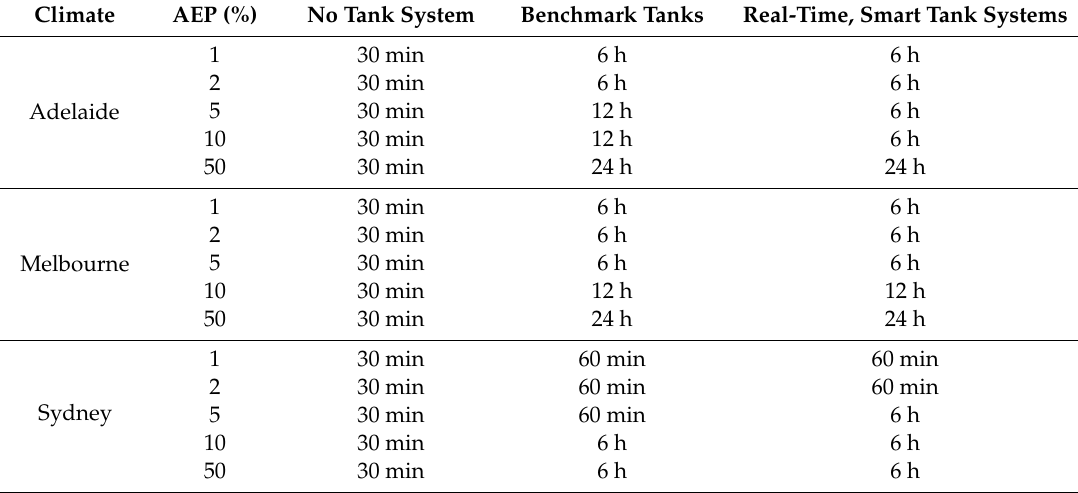
Table A2. Critical duration of no tank system, benchmark tanks and real-time, smart tank systems for a range of AEPs with 2 × 10 m 3 tanks in Adelaide, Melbourne and